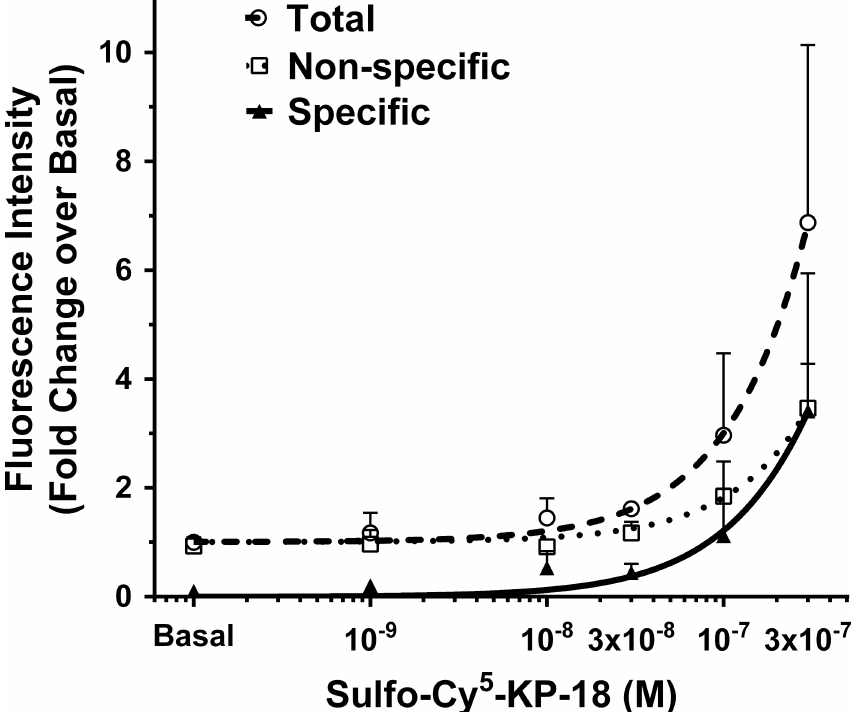
Fig 5. Binding of Sulfo-Cy 5 -KP-18 to kisspeptin receptor. HEK293 cells were transiently transfected with kisspeptin receptor and cultured for 48 hours. The cells were then incubated with increasing concentrations of Sulfo-Cy 5 -KP-18 at 4˚C for 4 hours. Total binding of Sulfo-Cy 5 -KP-18 was measured by fluorescence intensity after washing off free ligand. Non-specific binding was determined in the presence of 10 μ M KP-10. The mean fold-changes over the basal of the fluorescence intensity ± SD from three independent experiments were calculated and plotted. Specific binding was calculated by subtracting non-specific binding from the total. Total binding ( (cid:14) ; dash curve), non-specific binding ( □ ; dot curve) and specific binding ( ▲ ; solid